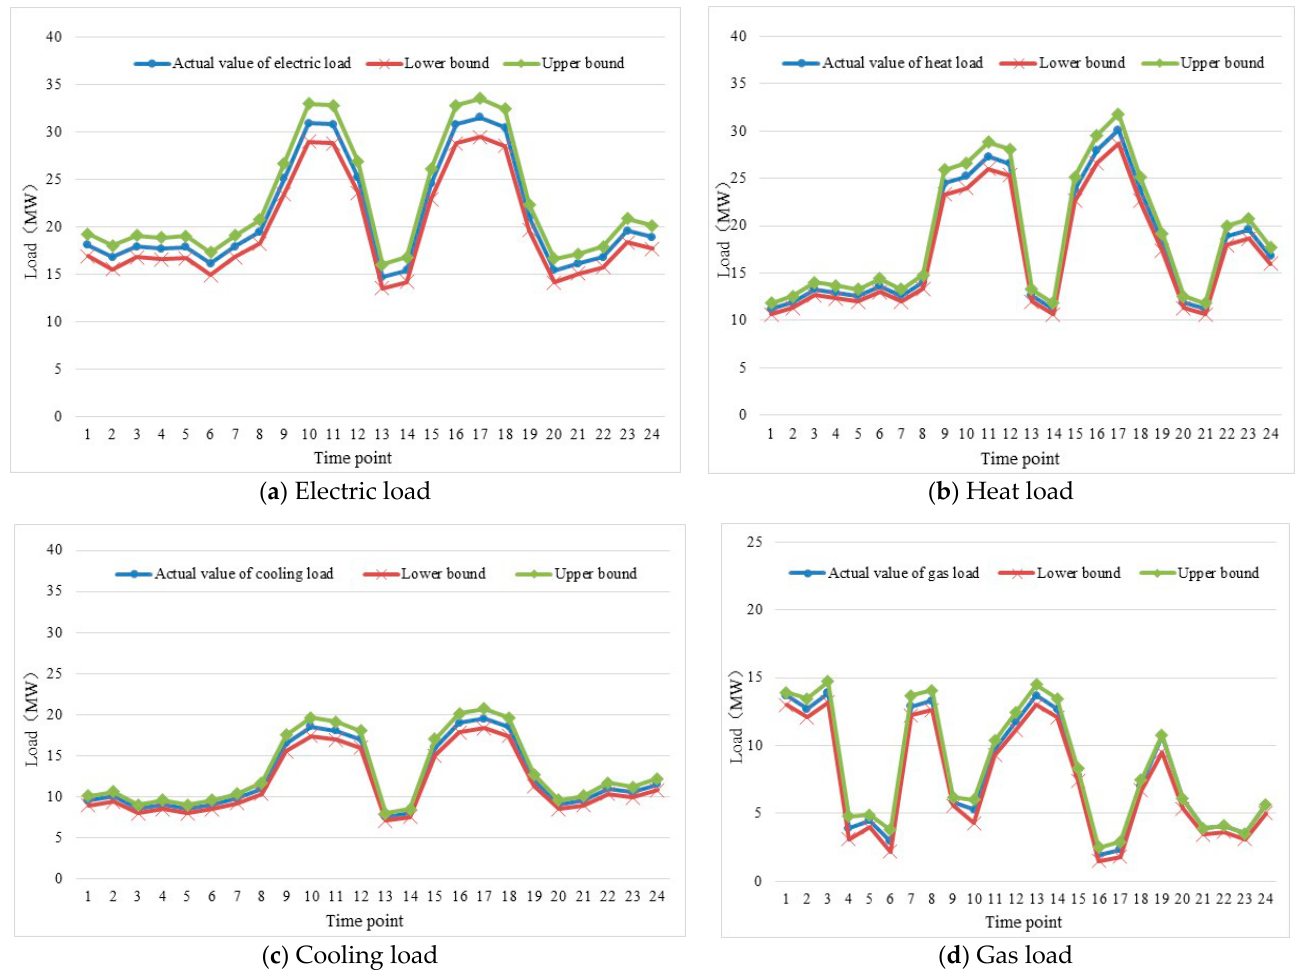
Figure 11. Multi-energy load forecasting results on the workday (MW).